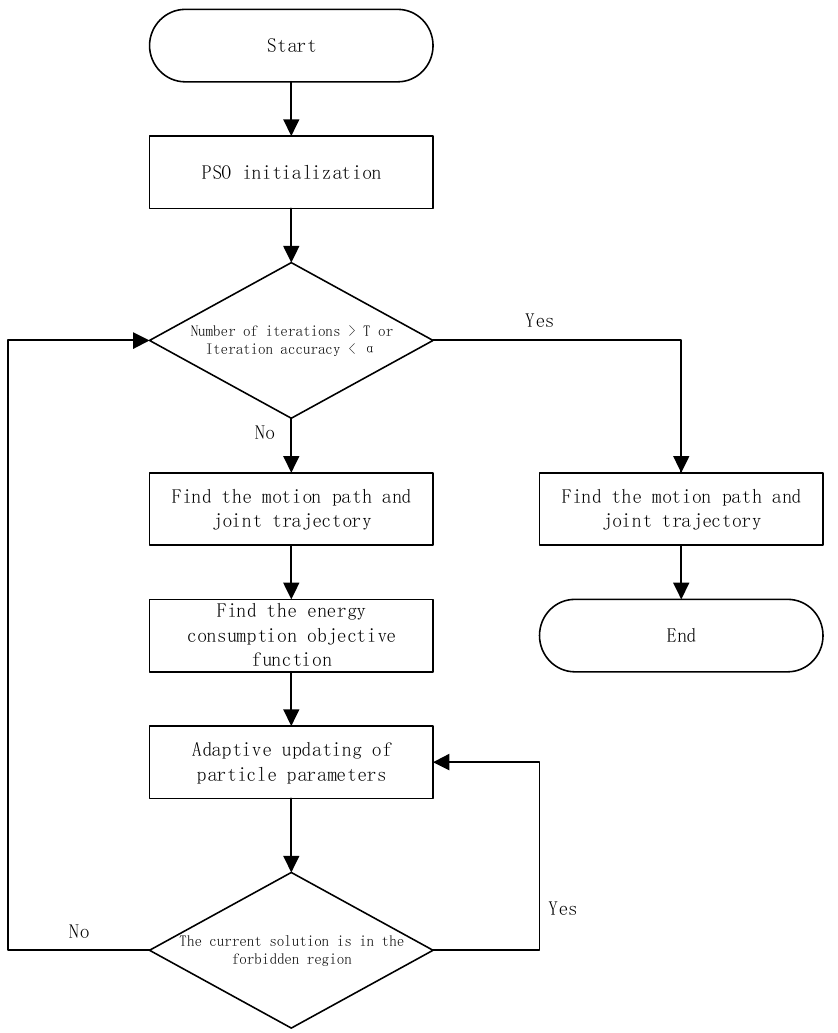
Figure 5. Improved flow chart of adaptive particle swarm